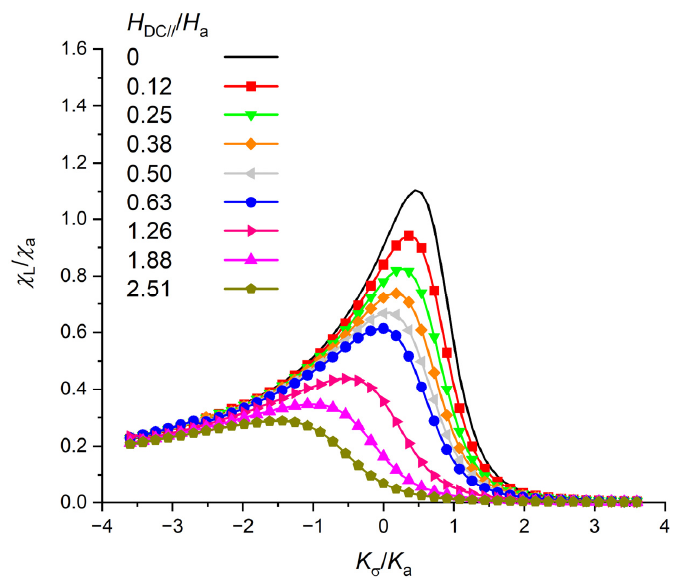
Figure 9. Relative susceptibility components ( χ L / χ a ) versus anisotropy ratio K σ / K a with λ s = 30 ppm for different longitudinal field.